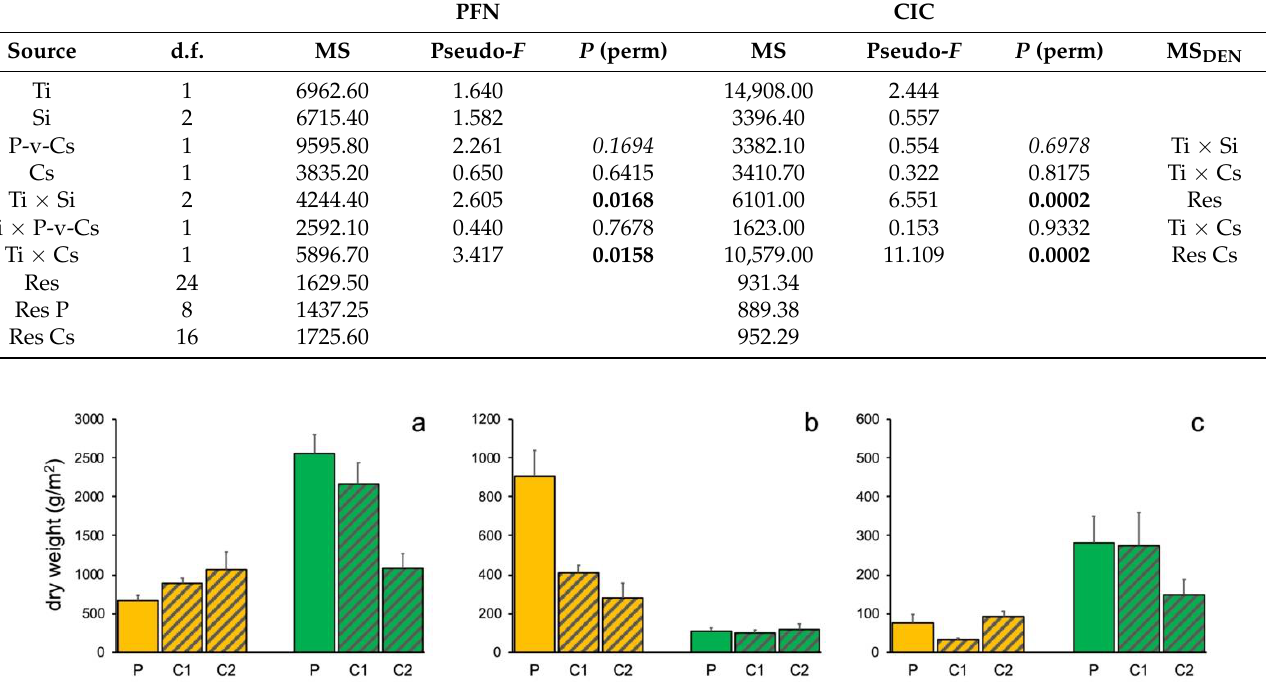
Figure 4. Mean ± SE ( n = 5) total biomass (dry weight) of ( a ) E. amentacea , ( b ) macroalgae, and ( c ) invertebrates at the fully protected site (P) and the two control sites (C1 and C2, dashed bars) of CIC in each sampling time. Time 1 (T1) = orange bars, Time 2 (T2) = green bars. Note that scales on y- axis are different.